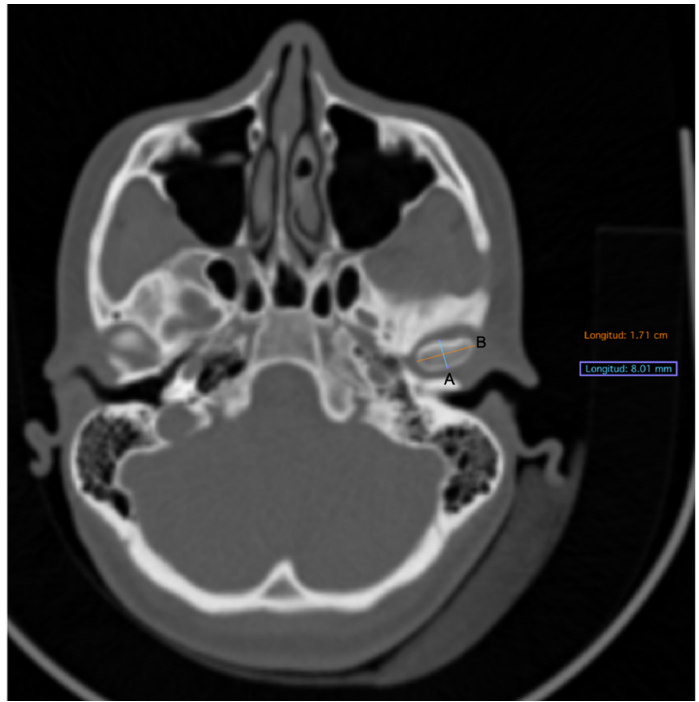
Figure 3 . Bone tissue CT, axial view. ( A ) Anteroposterior condylar length. ( B ) Midlateral condylar length.